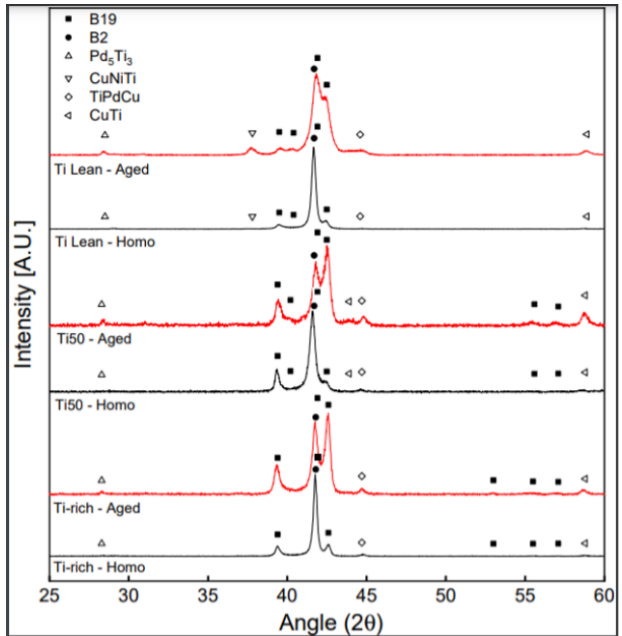
Figure 2. XRD Spectra of group A Ni-Ti-Cu-Pd alloys after homogenization (900 °C × 24 h) and aging (550 °C × 3 h). Matrix phases are represented by plain symbols and tetragonal precipitates by open ones.